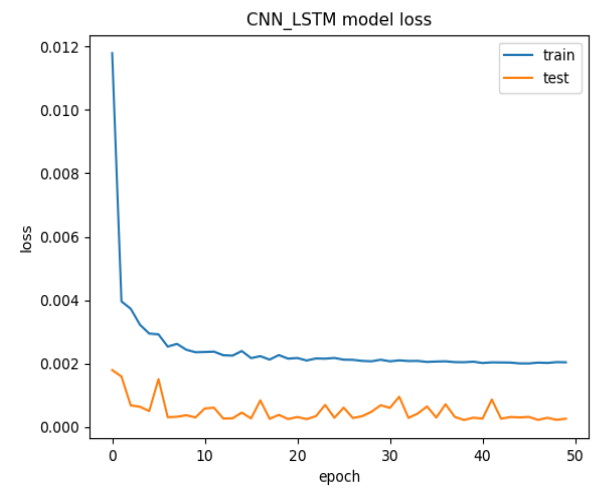
po s i t i on Figure 10. True position curve of pitch axis from data set. 3.2. Experiment Environment and Tools The experimental environment of this research was an AMD FX (tm)—4100 Quad - Core Processor, 16 GB of memory, the Windows 10 operating system, and Python 3.9, and PyCharm as development tools. In PyCharm, we used the data packets keras and sklearn. 3.3. Experiment Result We set epoch = 50 and batch_Size = 70. The change in the loss value with EPOCH is shown in Figure 11. The training set fluctuated in the early stage. With the increase in